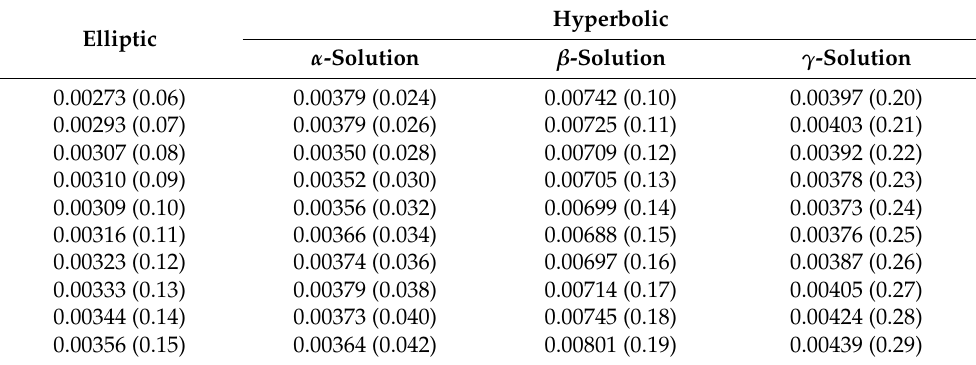
√ Table 9. The MSE of kernel regression method evaluated at bandwidth h (presented in parenthesis) in estimating the critical collapse response function g ( z ) = arg f 0 ( z ) in elliptic and hyperbolic cases based on a training sample of size n =